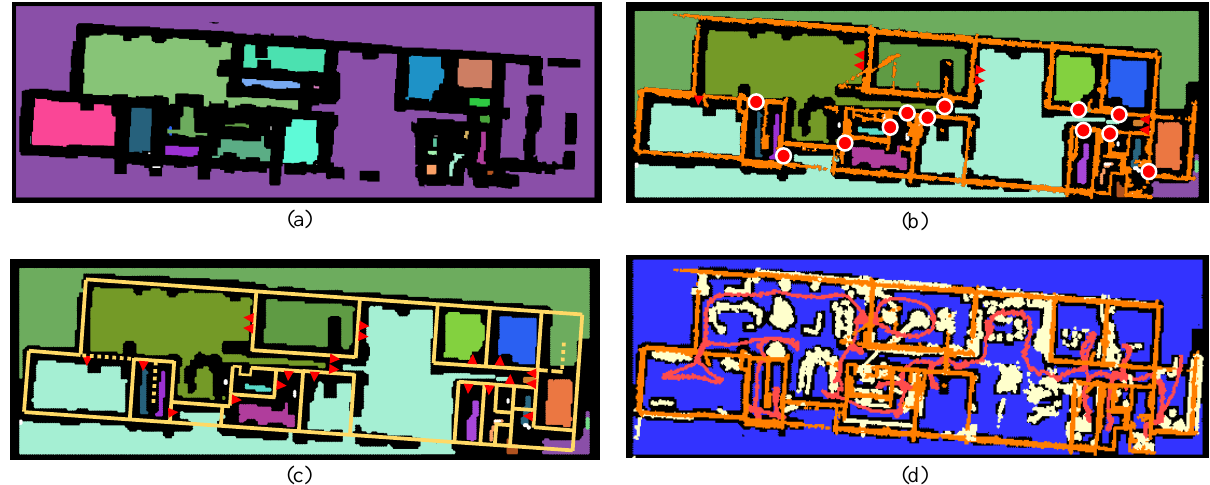
Figure 9. (a) Top view of space partitioning without using openings and wall information. Colored areas are empty spaces and black areas show the position of walls and clutter. (b) Space partitioning results after modification with openings and wall information. The overlaid orange layer show detected walls. Red dots show detected doors and red triangles show undetected doors. (c) Space partitioning and original floor plan. Light green area in the bottom of figure shows not correctly divided partitions. Small red triangles show the location of correct doors. (d) Navigable space (blue), clutter (yellow), and trajectory